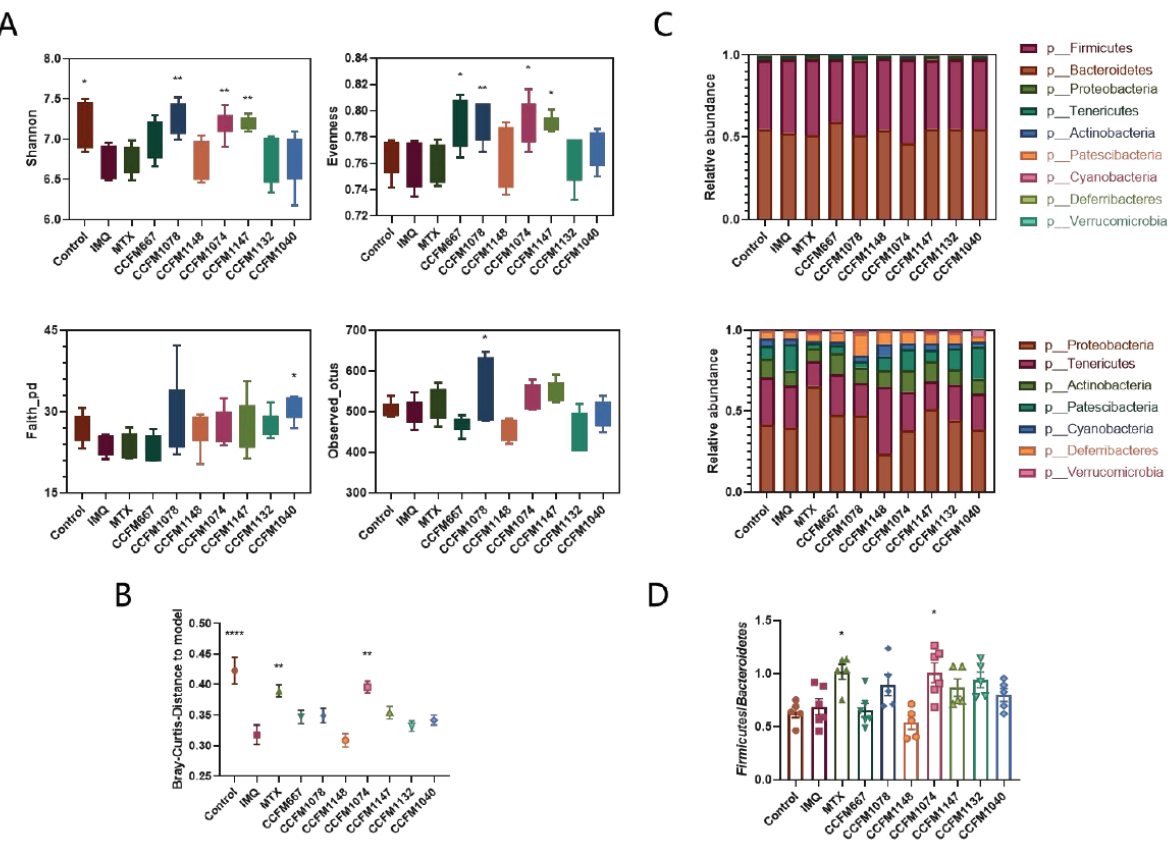
Figure 6. Effects of probiotics on gut microbial composition. ( A ) Alpha diversity and ( B ) beta diversity of gut microbiota ( n = 5/6). ( C ) The relative abundance of gut microbiota at the phylum level ( n = 5/6). OUT, operational taxonomic unit. ( D ) The rate of Firmicutes to Bacteroidetes. * p < 0.05, ** p <